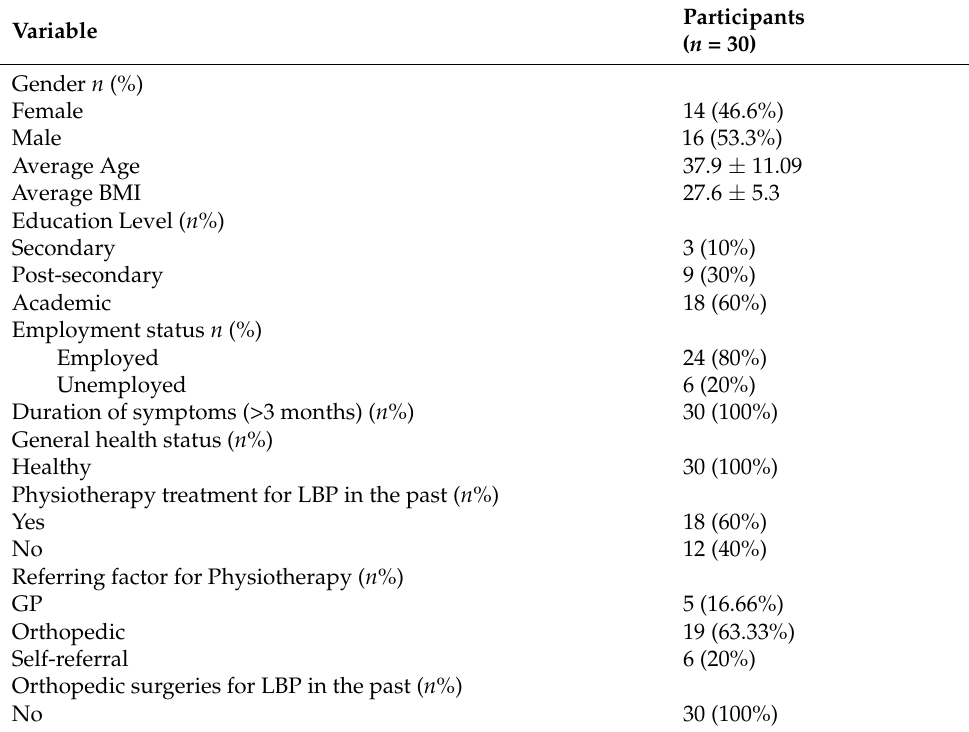
Table 3. Descriptive characteristics of the patients ( n =